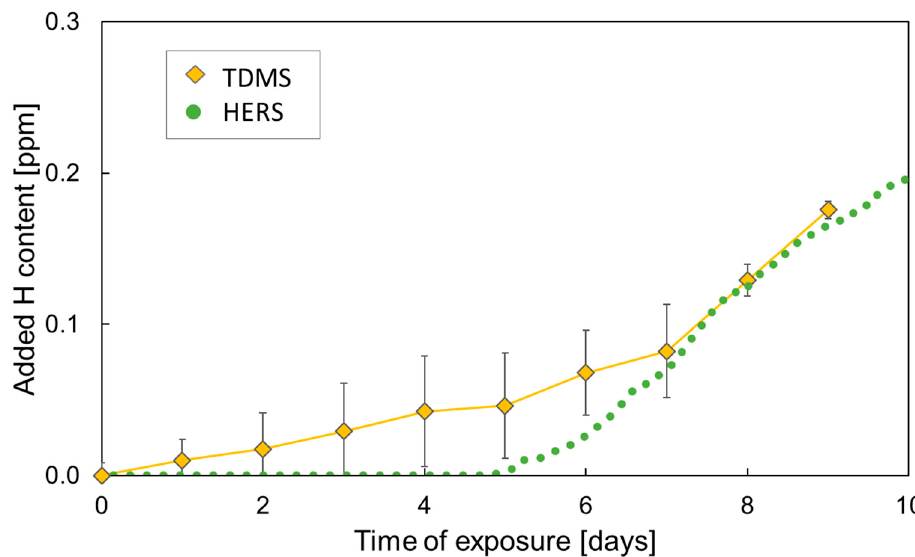
Figure 4. Comparison of TDMS and HERS measurements of added diffusible hydrogen content in DP1000 AHSS with NaCl deposits in humid air at 85% RH.